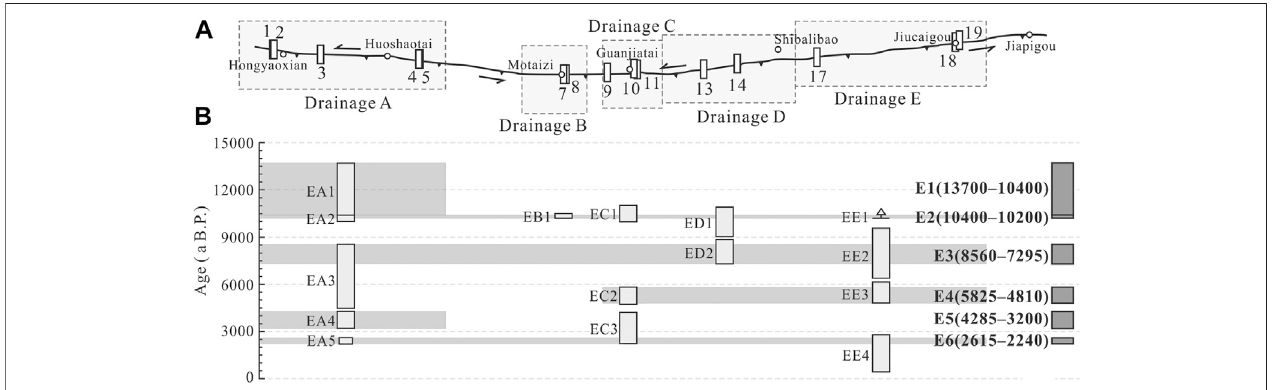
FIGURE4| AgelimitationofpaleoearthquakesoftheGulangfault. (A) DistributionmapoftheGulangfaultandtrenchlocations. (B) Paleoearthquakesequencesof fi ve drainages and the Gulang fault. Events marked bythe light gray boxes indicate the paleoearthquakes loggedin Drainages A, B, C,D, and E. The gray bars show the fault sections ruptured during the earthquakes. Events marked by the dark boxes are paleoearthquakes of the Gulang fault.